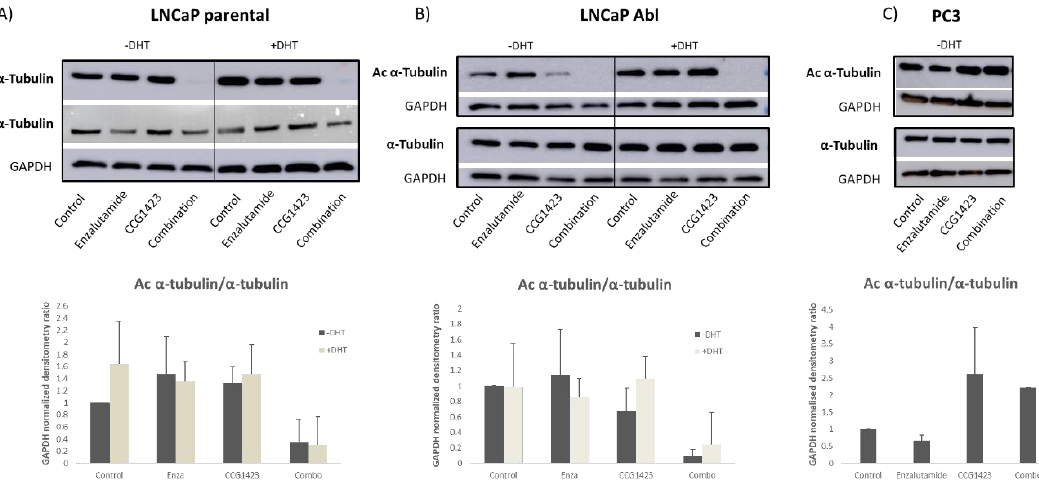
Figure 4. Protein expression of acetylated α -tubulin was assessed by Western Blotting (WB) following treatments as described in the Methods Section. ( A ) LNCaP parental; ( B ) LNCaP Abl; ( C ) PC3. Representative images of acetylated and total α -tubulin expression from three (LNCaP parental and Abl) and two (PC3) independent experiments are shown (top panel). Bottom panels show averages of densitometry analysis of WB images from three (LNCaP parental and Abl cells) and two (PC3) independent experiments ± standard deviation. Bars represent the ratio between acetylated α -tubulin and α -tubulin, following normalisation with GAPDH (to control for loading of proteins).